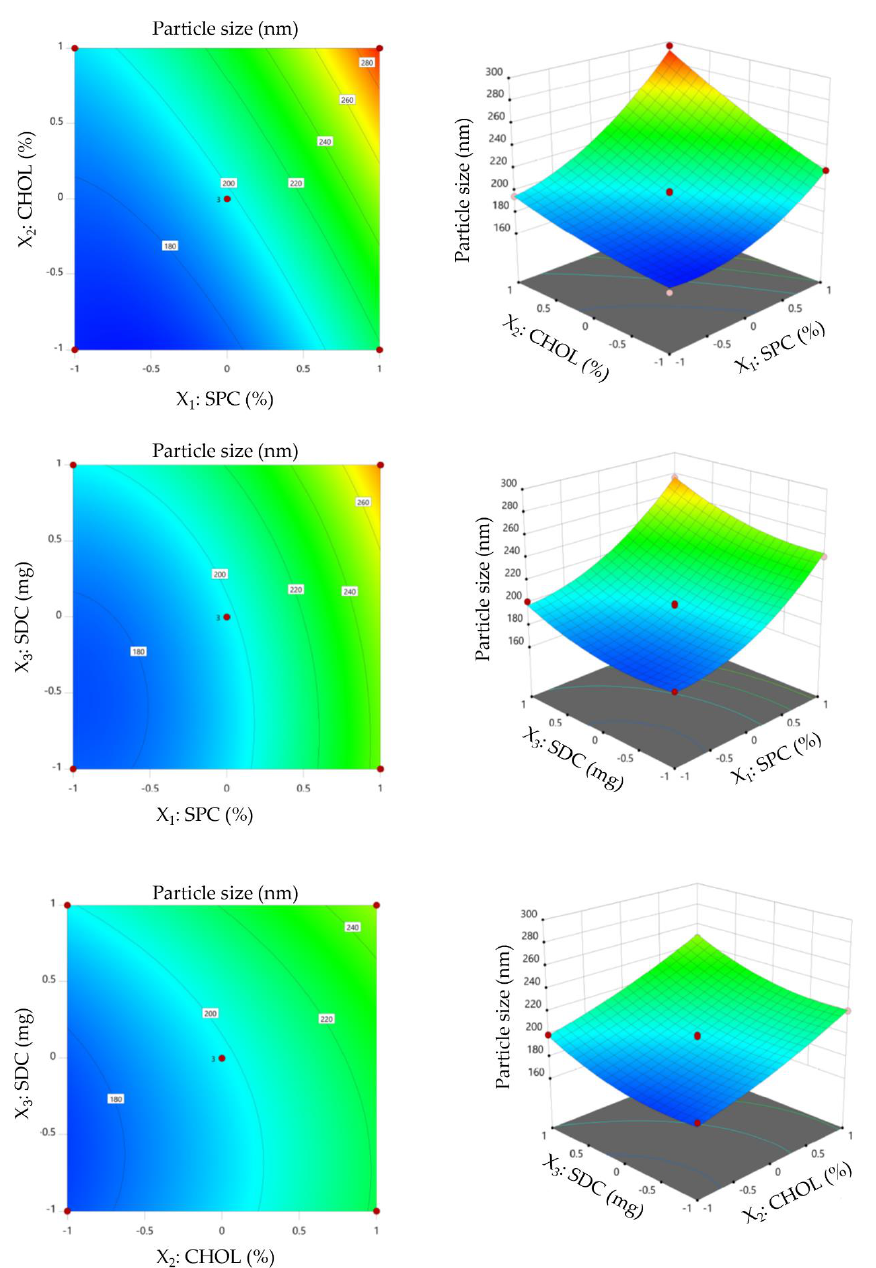
Figure 1. Contour and 3D surface plots showing the influence of independent variables (SPC, CHOL, and SDC) on bilosomal size.